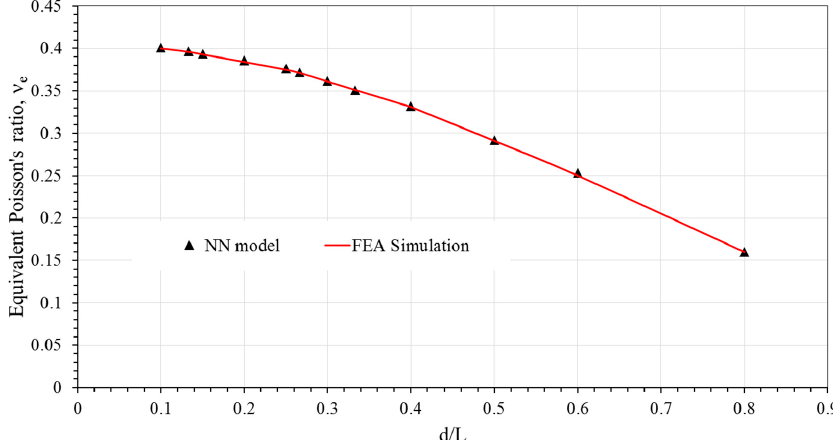
Figure 7. Comparison of equivalent Poisson’s ratio from FEA simulation and NN model for BCC pattern. J. Compos. Sci. 2018 , 2 , x